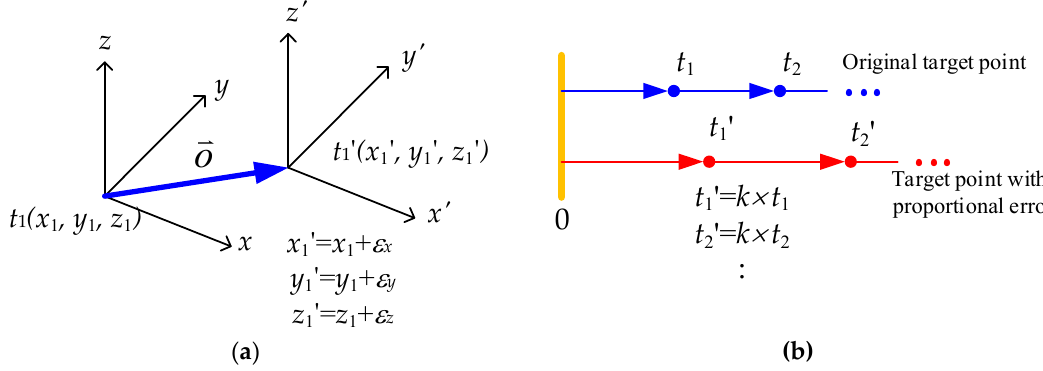
Figure 4. Illustration of the simulation for machine tool moved with positioning error: ( a ) coordinate offset; and ( b ) proportional error. (Note: vector t i represents the i -th target point; k represents the proportional value; and t 1 represents the i ‐ th target point with coordinate offset or proportional error).